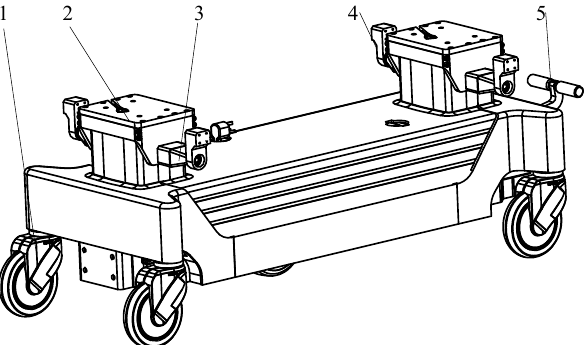
Figure 13. The structural design of the lifting part; 1—the castor; 2—the fixed plate of the lifting columns; 3—the connecting shaft; 4—the bearing support; 5—the brake.